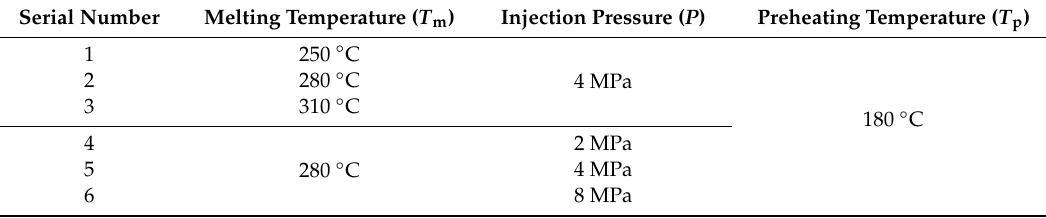
Table 2. Main thermoplastic composite over-molding (TCO) processing parameters for short glass fiber reinforced polyamide 66 (SFR-PA66) / continuous glass fiber reinforced polypropylene (CFR-PP) hybrid